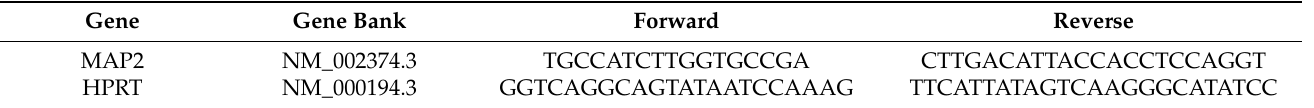
Table 1. Primer sequences used for real-time quantitative polymerase chain reaction analysis.